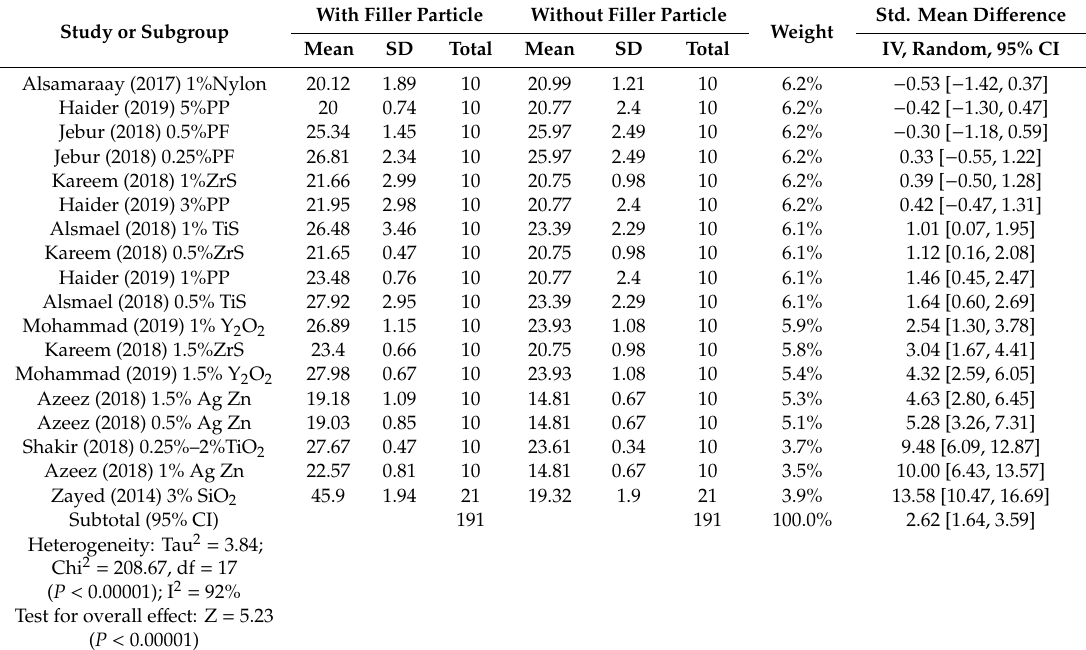
Table 5. Summary findings and forest plot of tear strength (N / mm) outcomes in case-control studies incorporating filler particles with